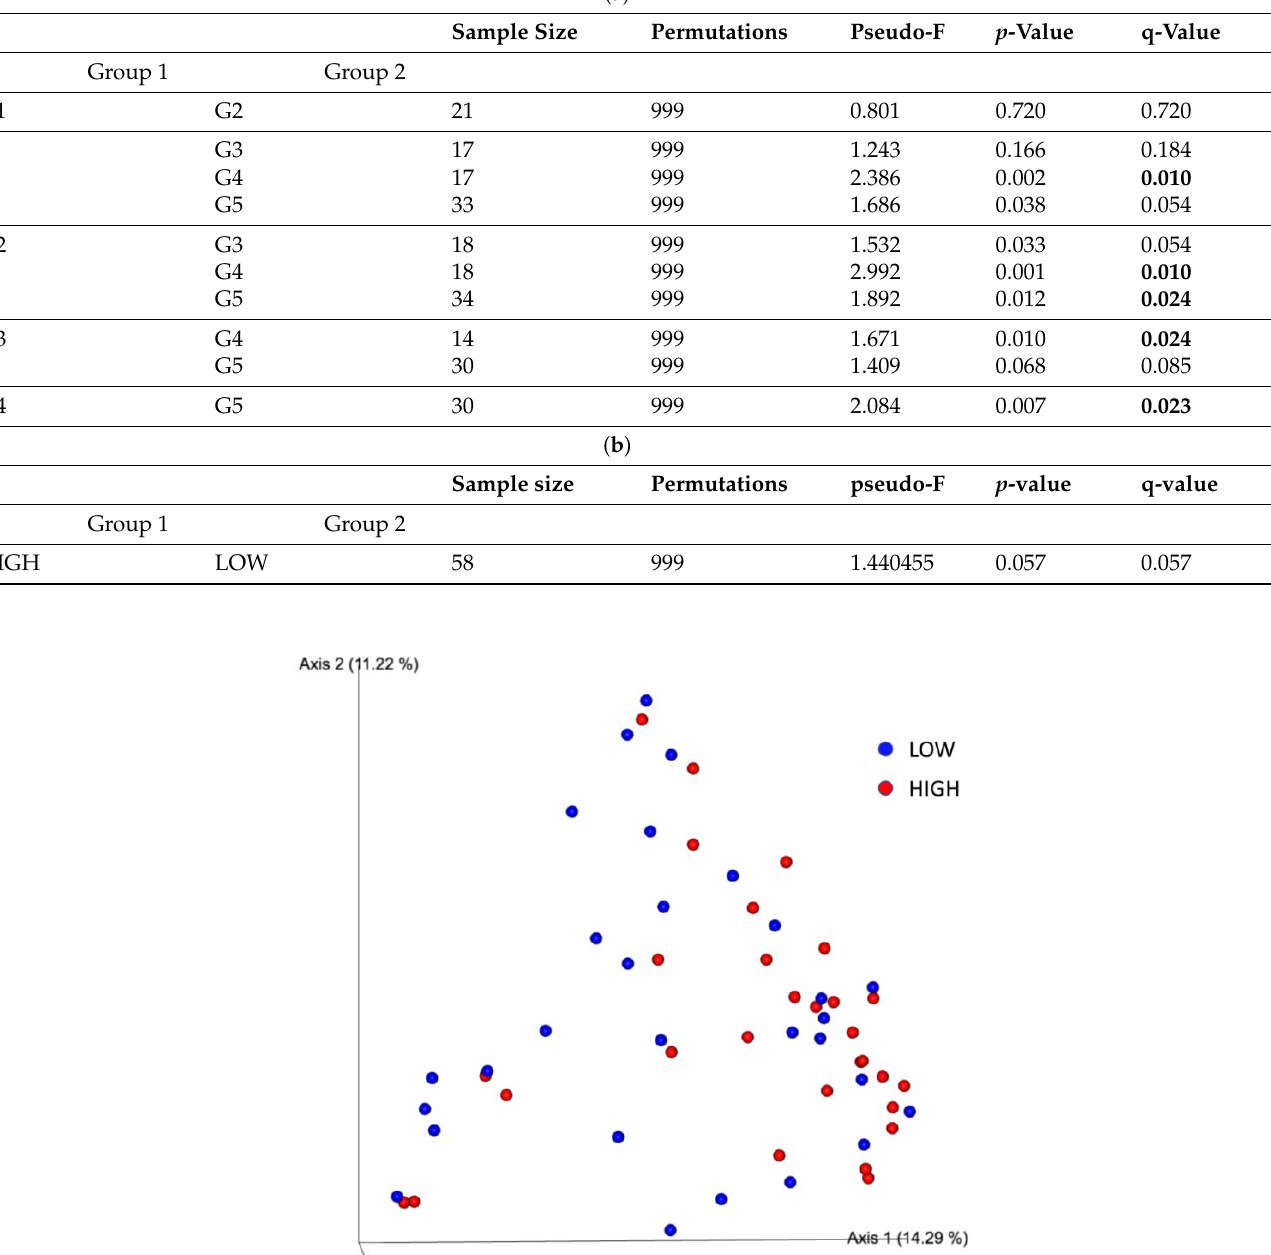
Table 1. Pairwise PERMANOVA results. ( a ) Group comparisons regarding geographic origin; ( b ) Group comparisons regarding high and low alkalinity. Bold values indicate q < 0.05.